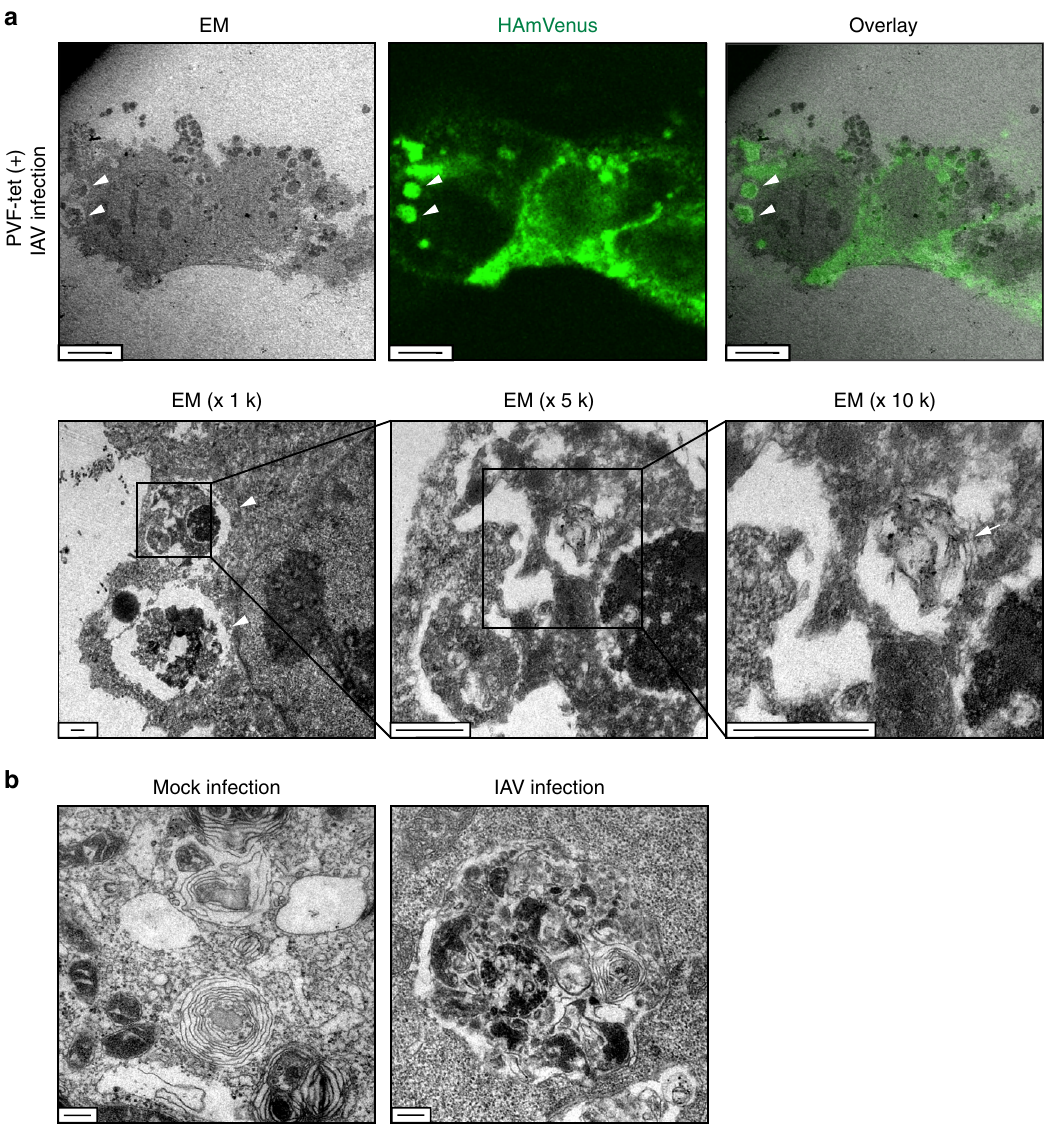
Fig. 5 The HA-containing structures have not only lamellar membranous features but also electron-dense core features. a Correlative fl uorescence and electron microscopy (EM) of MDCK cells stably expressing HAmVenus. The cells were infected with IAV strain PR8 at 10 MOI for 1 h. After washing, the cells were cultured in the presence of PVF-tet (20 μ M ) for 15 h. Arrowheads indicate the HA-containing structures; the arrow in the last panel indicates the lamellar membrane. b Electron microscopy of MDCK clone 6. The cells were not infected or infected with IAV strain PR8 at 2 MOI for 1 h. After washing, the cells were cultured for 15 h. Scale bars represent 6 μ m ( a , upper panel), 500 nm ( a , lower panel), or 200 nm b ,